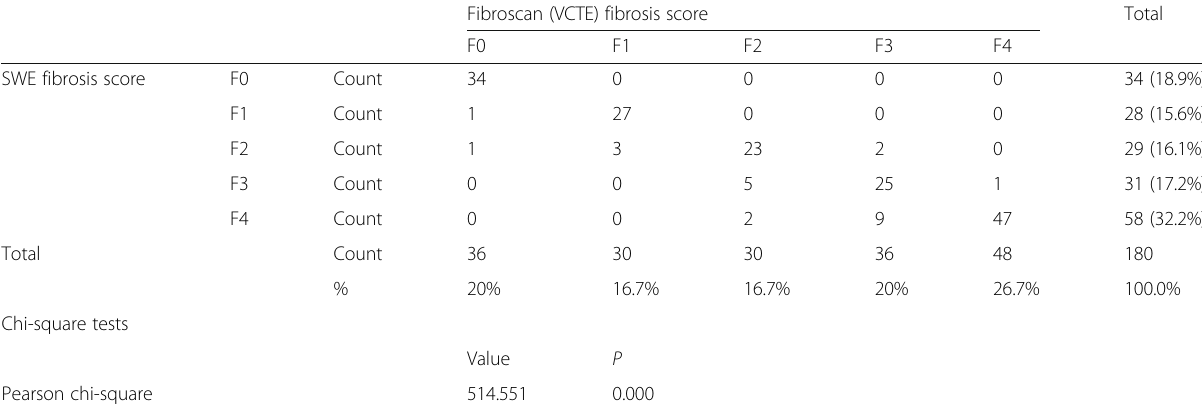
Table 5 The results of fibrosis score between the selected population using both fibroscan and SWE technique with the fibroscan results used as the reference